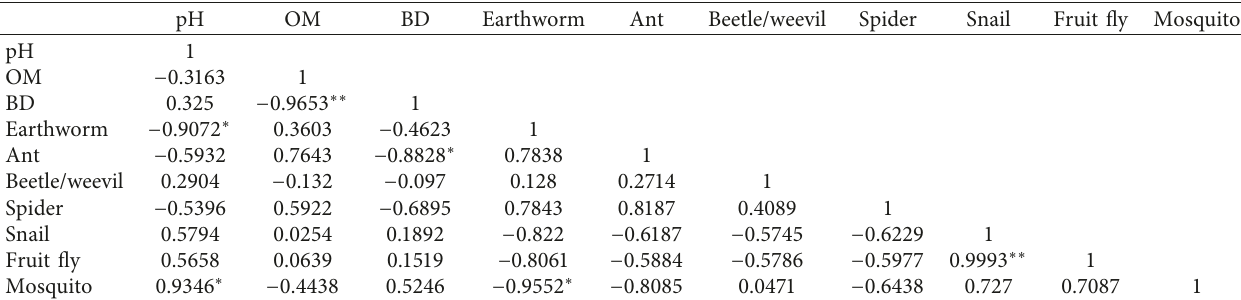
Table 5: Pearson’s correlation matrix of some selected soil physicochemical properties and macrofauna